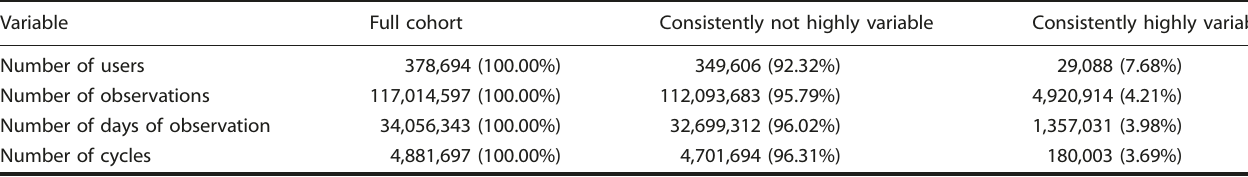
Table 1. Summary statistics of the full cohort.